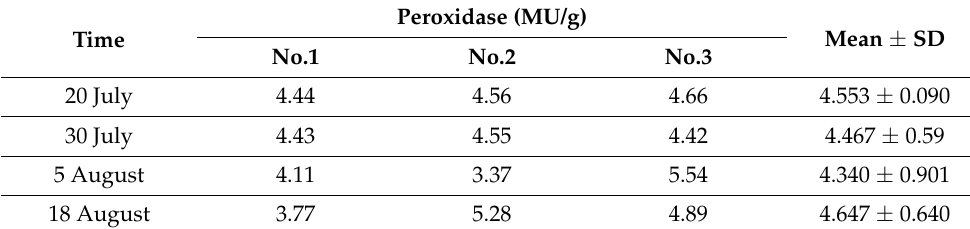
Figure 2. Changes in peroxidase in host leaves at different times of injury. Table 2. Measuring peroxidase in host leaves at different times of